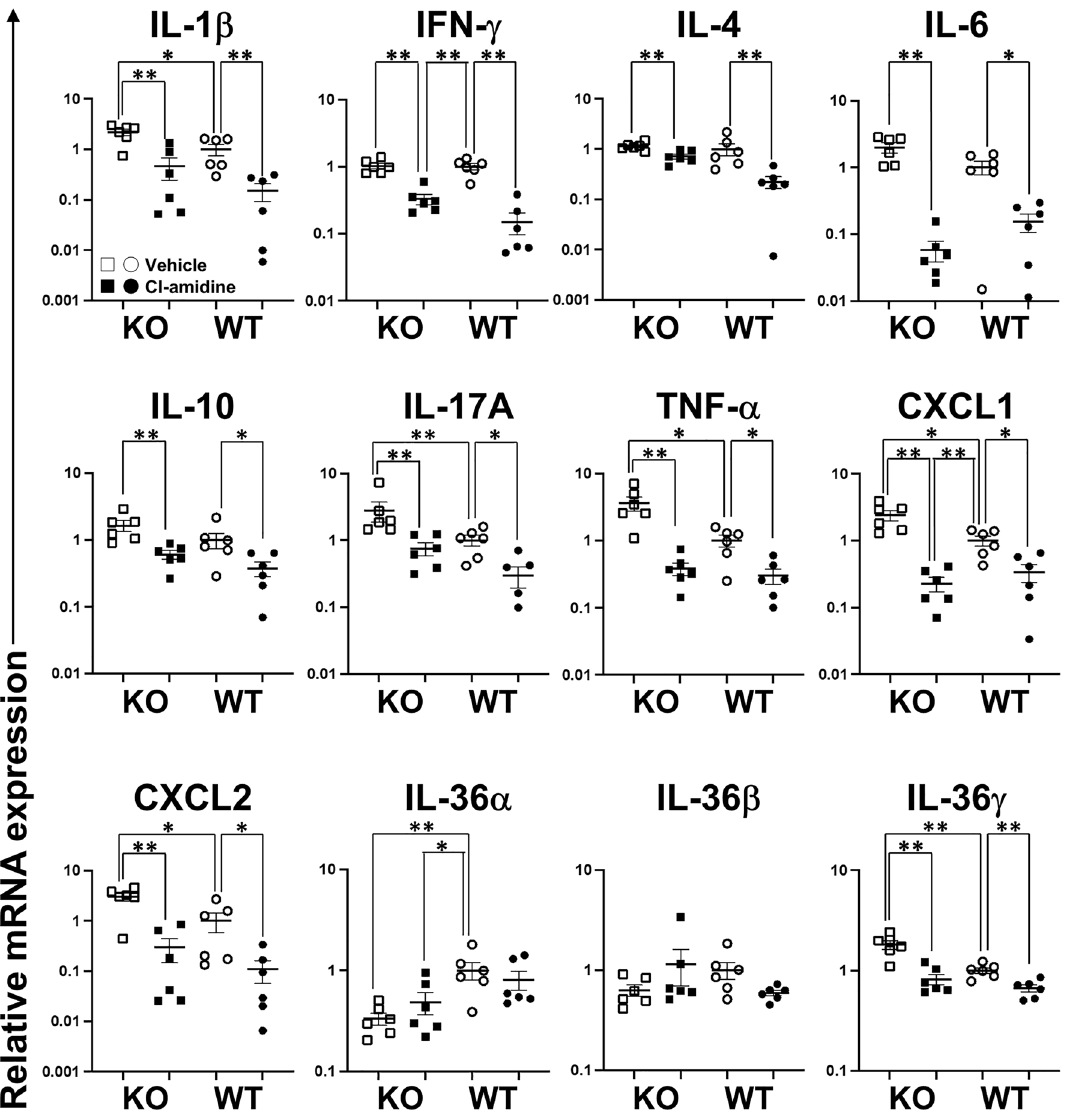
Figure 4. Effect of Cl-amidine on the mRNA expression levels in the skin during the contact hypersensitivity response in wild-type mice (WT) and Il36rn −/− mice (KO). Relative mRNA expression of interleukin (IL)-1β, IFN-γ, IL-4, IL-6, IL-10, IL-17A, tumor necrosis factor alpha (TNF-α), C-X-C motif chemokine ligand (CXCL) 1, CXCL2, IL-36α, IL-36β, and IL-36γ was quantified using real-time reverse transcription polymerase chain reaction and normalized to endogenous glyceraldehyde-3-phosphate dehydrogenase mRNA expression levels. All values represent the mean ± SEM obtained from six mice per group (* p < 0.05, ** p <